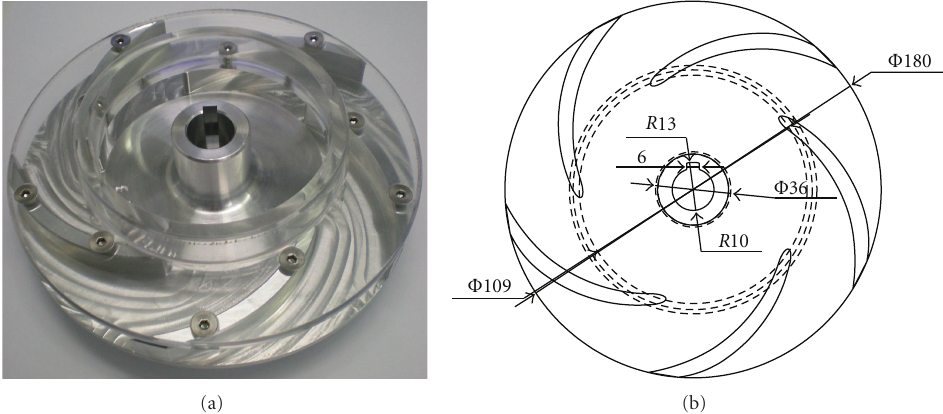
Figure 5: The examined impeller geometry and the scaled drawing (in mm) with blade leading edge angle of